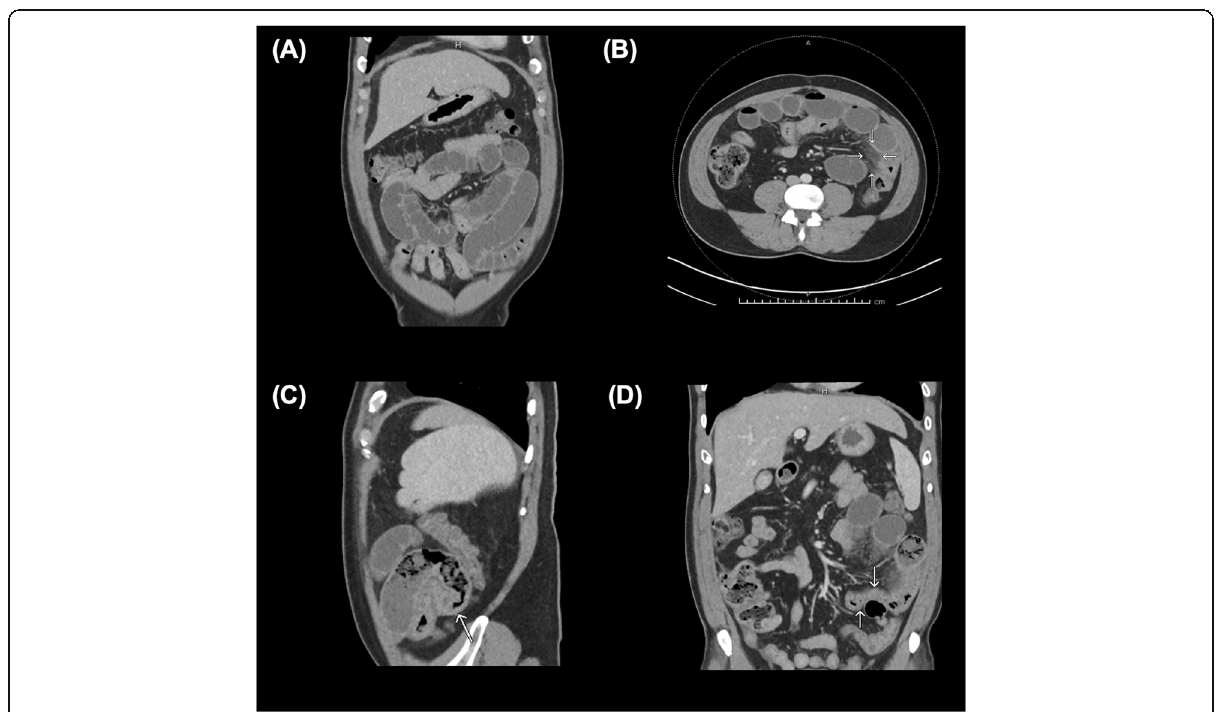
Fig. 1 CT abdomen/pelvis with contrast. The CT scan of this CF patient demonstrated dilated loops of bowel proximally ( a ), with associated mesenteric venous congestion ( b ). Additionally, a transition point ( c ) was noted in the left hemiabdomen, distal to which the small bowel was decompressed ( d ). Just proximal to the transition point, gas bubbles and particulate matter were noted, suggestive of fecal contents in the small